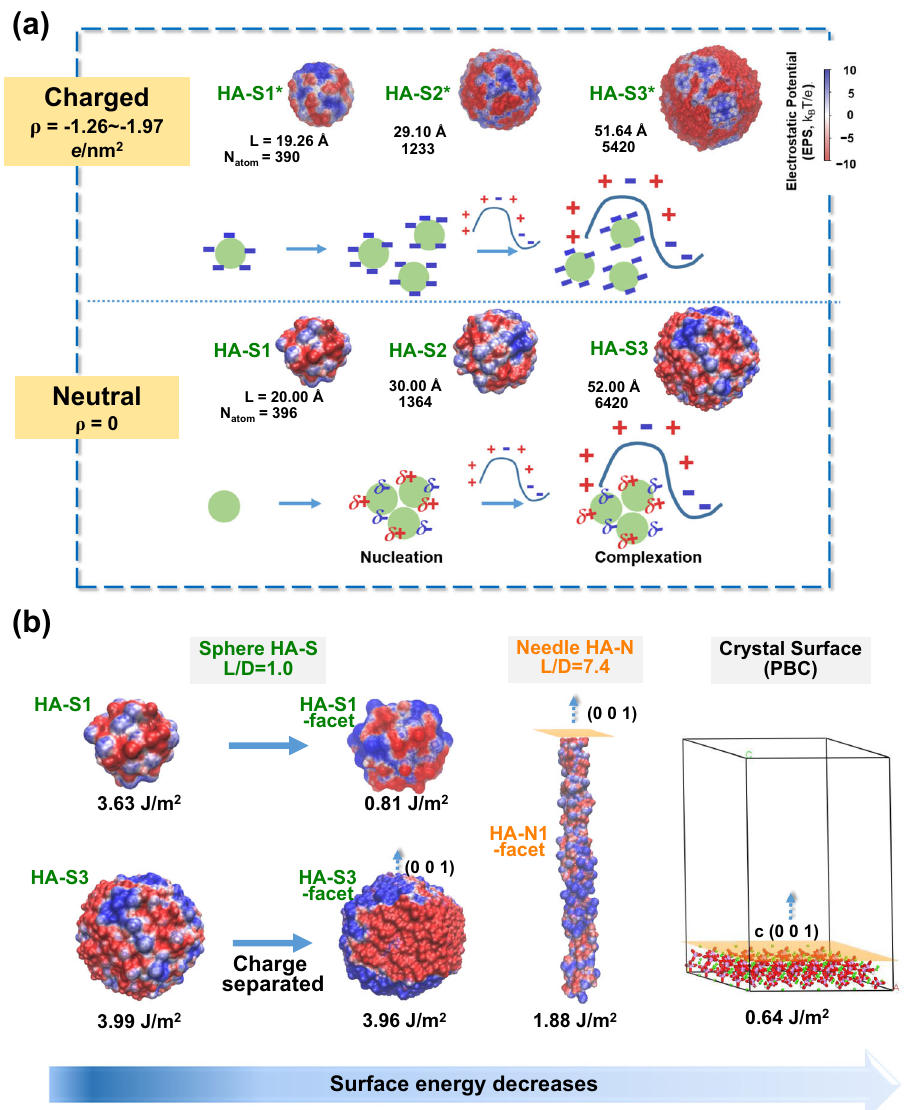
Fig. 8 Electrostatic potential surface and implications for nucleation and complexation. a Electrostatic potential surface (EPS) of HANPs in different charge states, charged versus neutral. b EPS and surface energies for some selected morphologies, in which the appearance of the faceted (0 0 1) lowers the surface energy of a